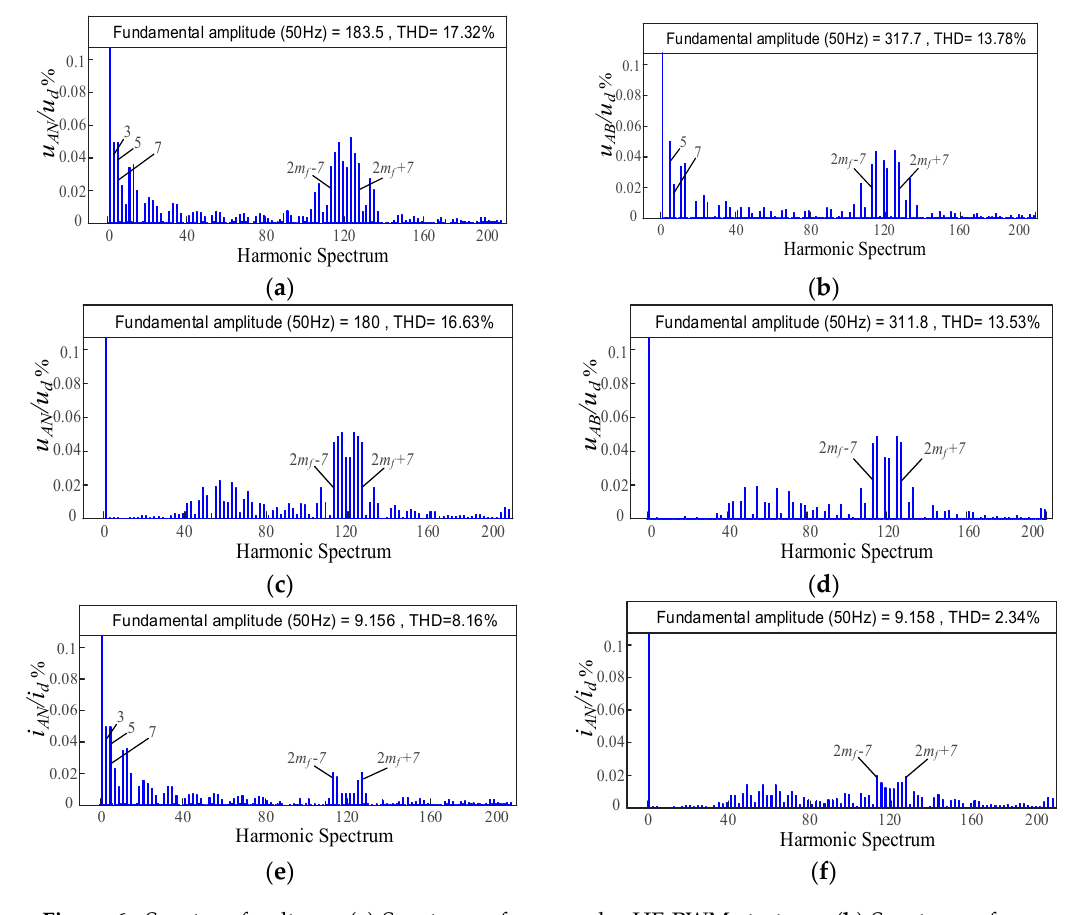
Figure 6. Spectra of voltage. ( a ) Spectrum of u AN under HF-PWM strategy. ( b ) Spectrum of u AB under HF-PWM strategy. ( c ) Spectrum of u AN under MHF-PWM strategy. ( d ) Spectrum of u AB under MHF-PWM strategy. ( e ) Spectrum of u AN under HF-PWM strategy. ( f ) Spectrum of u AN under HF-PWM strategy.